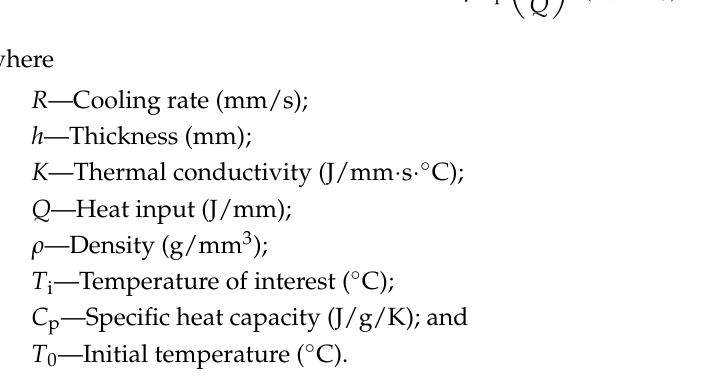
Table 8. Weld centerline cooling rates for sample P300_N_P300_W4_P0. Pass R K ρ C p h Q T i T 0 1st 4.18 0.28 550 250 * 2nd 2.42 0.28 3rd 2.42 0.28 0.0071 4th 550